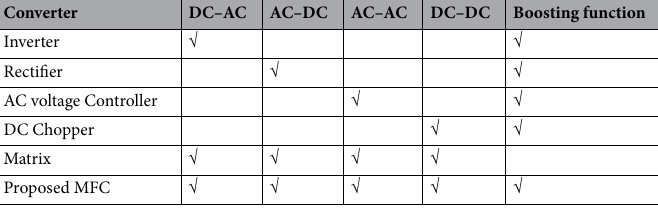
Table 1. Comparison among the existing converters and the proposed MFC.